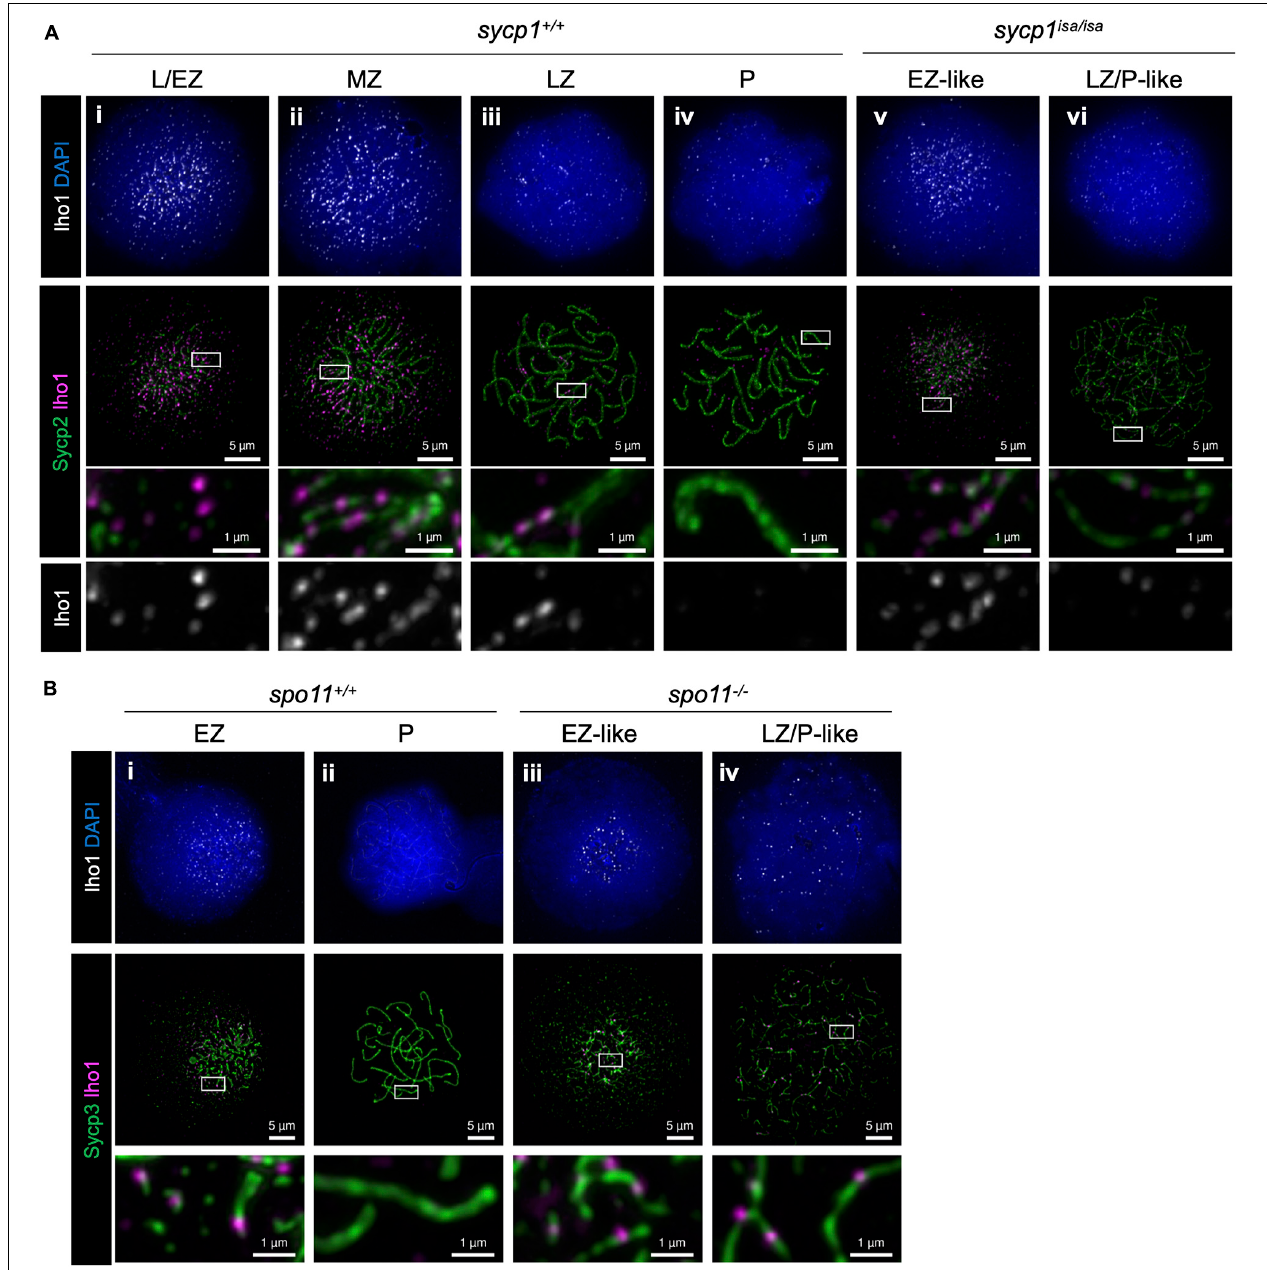
FIGURE 8 | Iho1 localization in sycp1 and spo11 m utant spermatocytes. (A) costaining of Iho1 and Sycp2 in sycp1 + / + (i to iv) and sycp1 isa / isa (v and vi) spermatocytes. Regions marked in white rectangles are shown at a higher magnification at the bottom. (B) Costaining of Iho1 and Sycp3 in spo11 + / + (i and ii) and spo11 − / − (iii and iv) spermatocytes. Regions marked in white rectangles are shown at a higher magnification at the